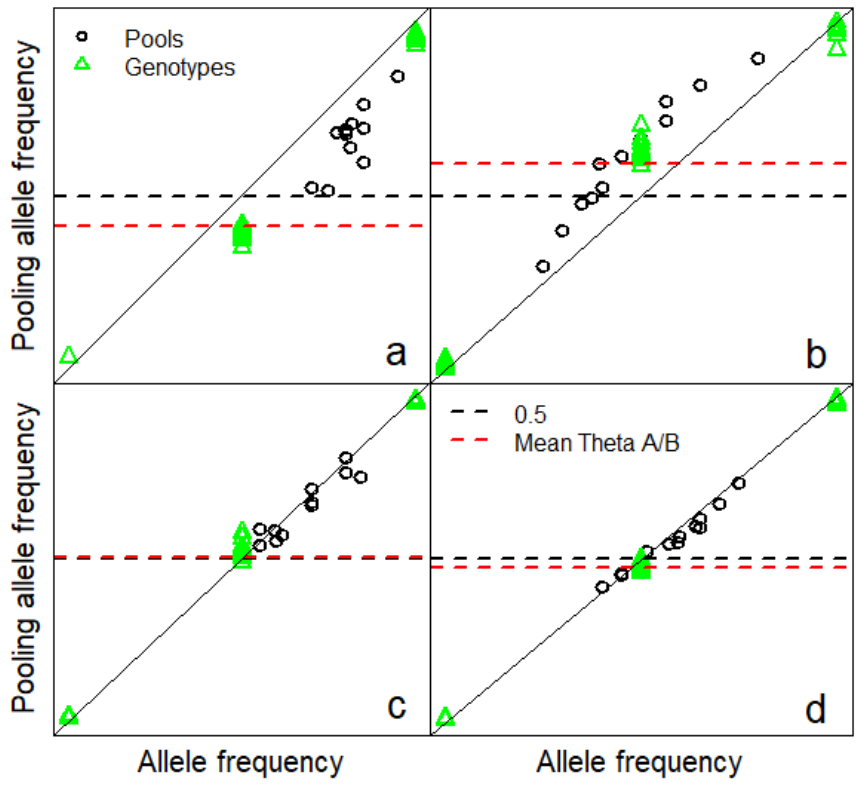
Figure 3. Technical error expressed as deviations of observed pooling allele frequency from allele frequency. All vertical and horizontal coordinates in this figure range from 0 to 1. Pooling allele frequency was estimated as Illumina θ = 2 * tan − 1 (Y/X)/ π in this study where Y/X is the allelic ratio for green/red intensity for both pools and individuals. Considering pooling allele frequency for individuals is not ridiculous, because individuals are technically a pool of two haplotypes with equal representation. Technical error varies within and between SNP, and we present four examples, ( a – d ). ( a ) Pooling allele frequency was low compared to allele frequency for both pools and heterozygotes which was consistent with low mean Illumina θ for heterozygotes (depicted A/B in figure legend. ( b ) Pooling allele frequency and mean heterozygote Illumina θ were high compared to allele frequency. ( c , d ) Pooling allele frequency and mean heterozygote Illumina θ were similar to allele